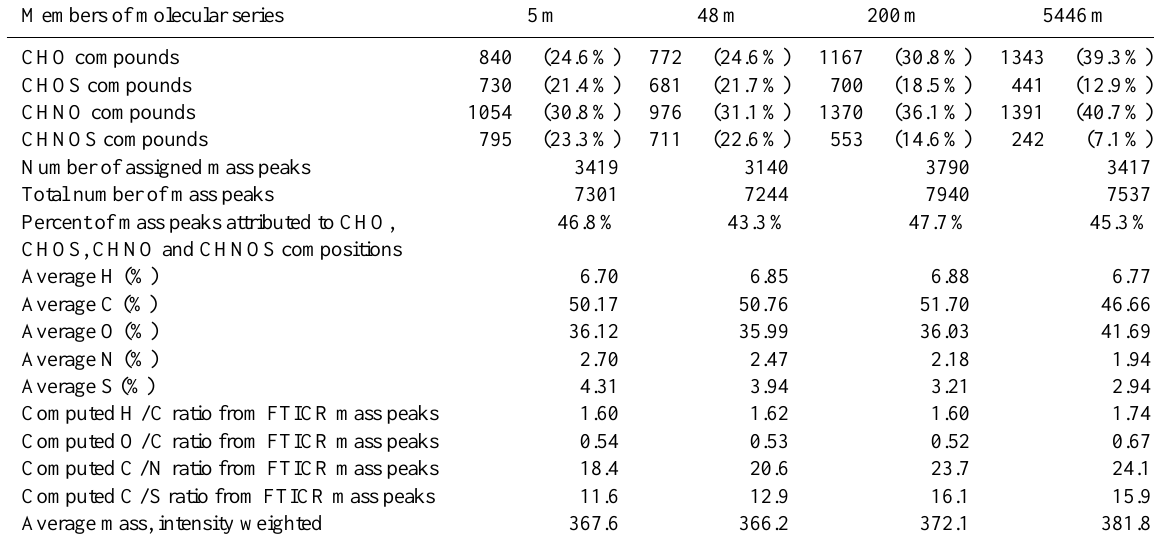
Table 4. Counts of mass peaks as computed from negative electrospray 12TFTICR mass spectra for singly charged ions with nitrogen rule check and 500ppb